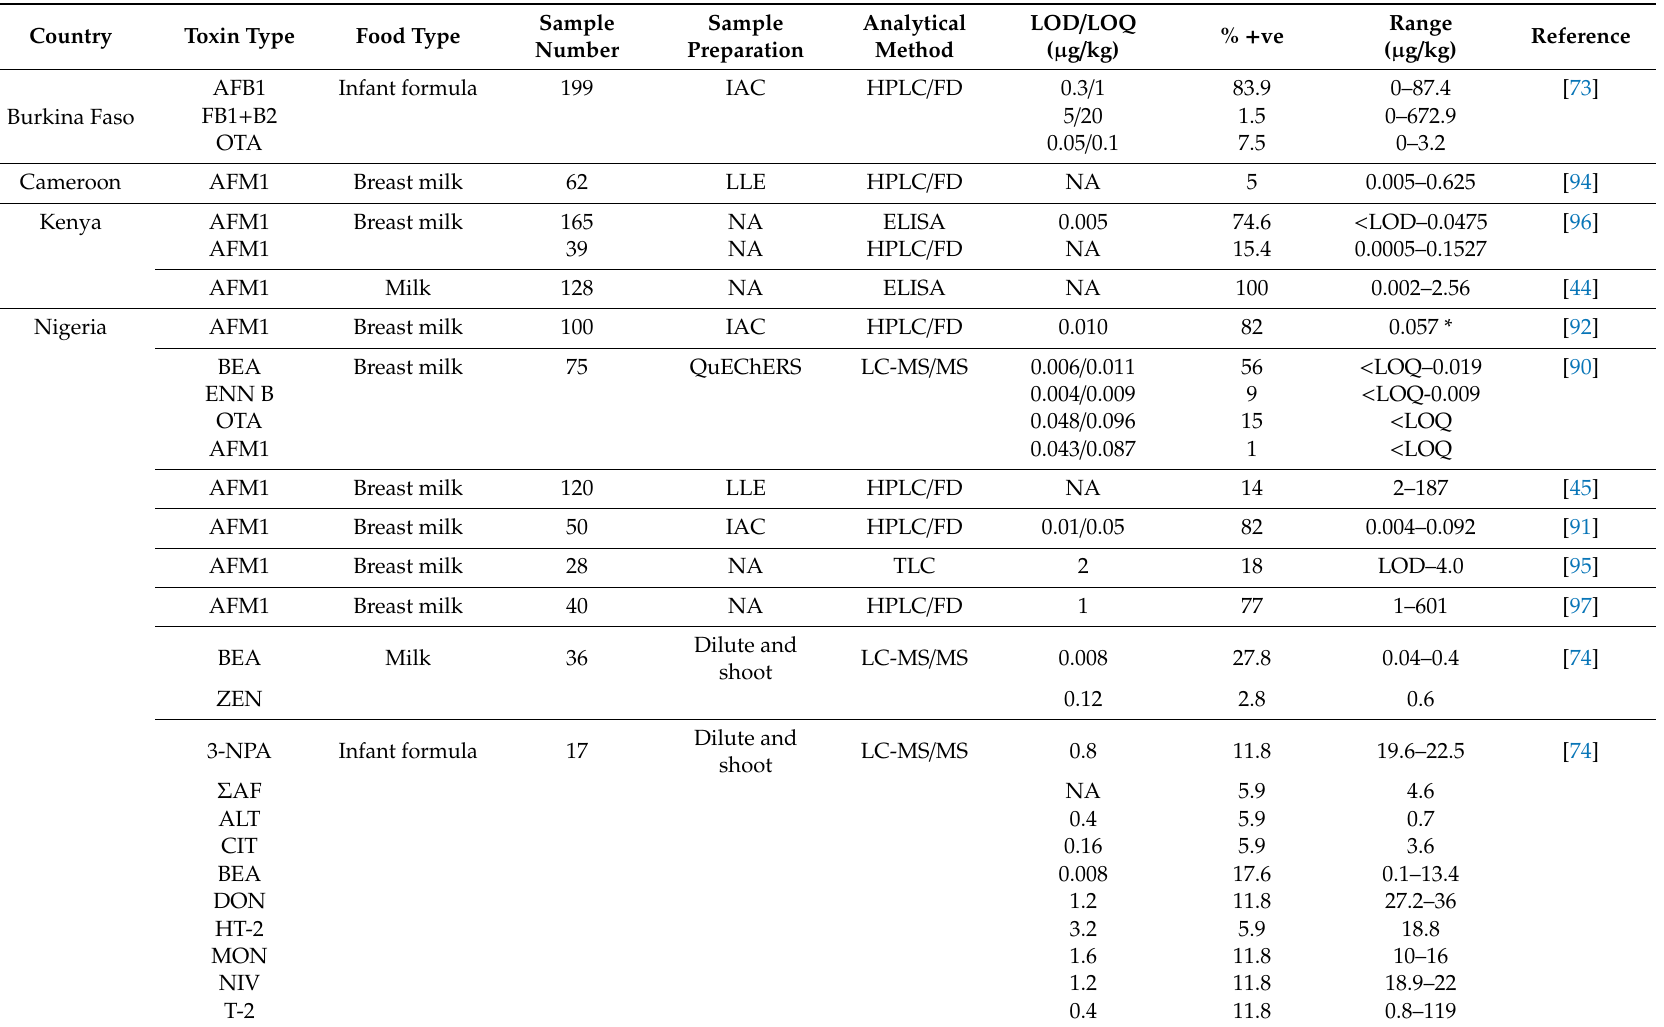
Table 2. Mycotoxin contamination of infant formula, milk, and human breast milk originating from sub-Saharan